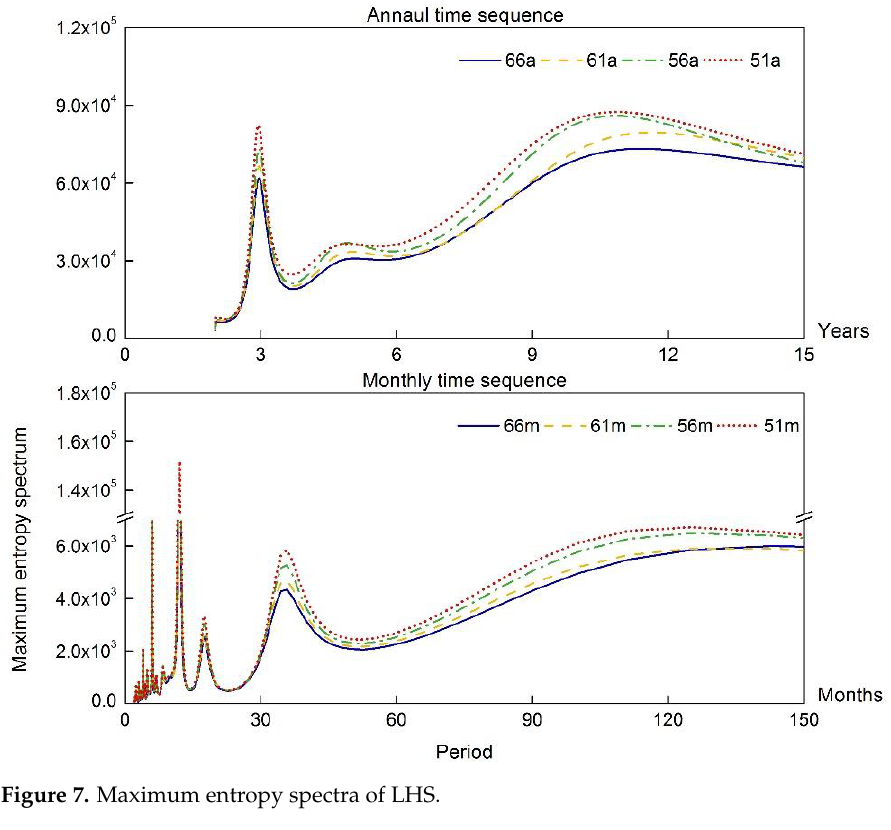
Figure 7. Maximum entropy spectra of LHS.